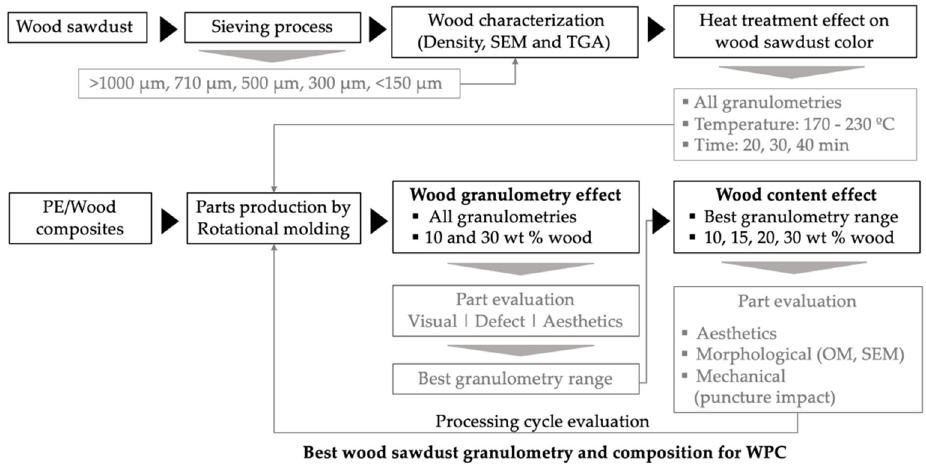
Figure 2. Flow chart summarizing the methodology followed for the work.